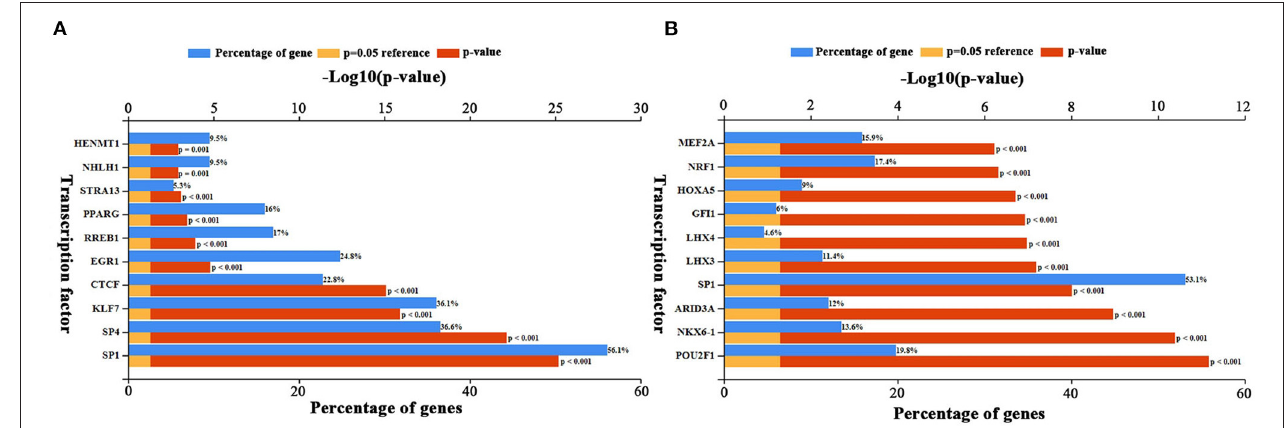
FIGURE 5 | Predicted transcription factors of DEGs. (A) Transcription factors of up-regulated DEGs. (B) Transcription factors of down-regulated DEGs. The blue bars indicate the percentge of genes enriched to the transcription factor. The yellow bars indicate the reference significant enrichment ( P -value = 0.05). The red bars indicate significant enrichment.